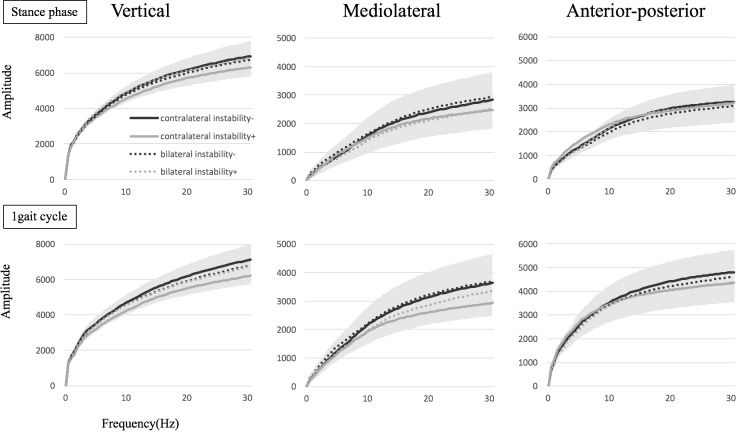
The cumulative amplitude in the frequency < 30 Hz in the fast Fourier transform (FFT) among four groups with or without subjective instability in the contralateral or bilateral implanted knees is shown.The colored range means standard deviation (SD) in all groups.